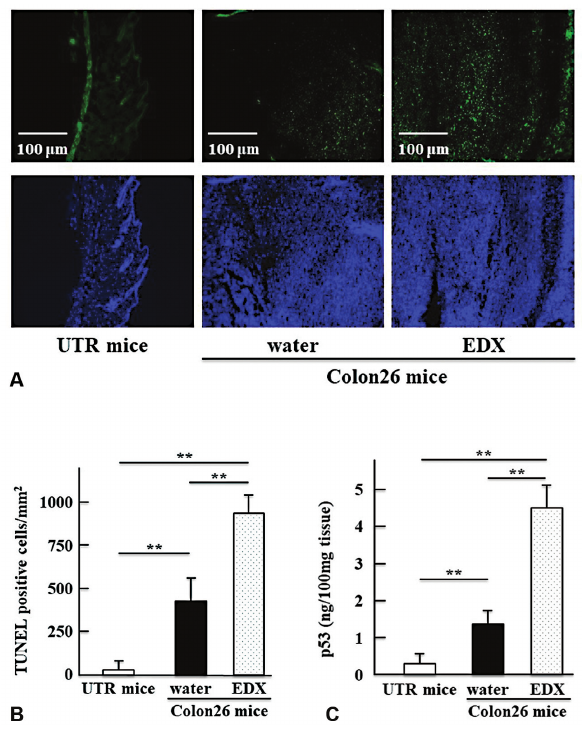
21. ( B ) TUNEL-positive cells/mm 2 in each group of tissues shown in